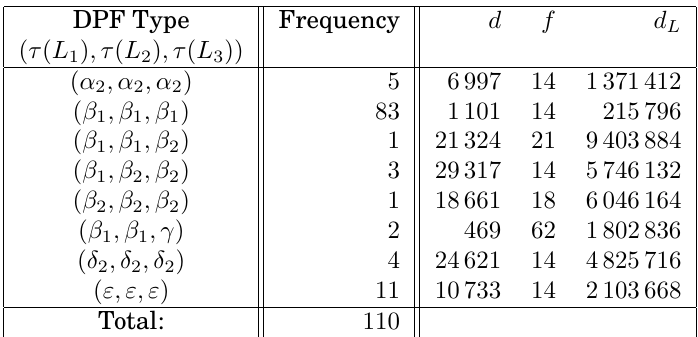
Table 27: Types of triplets with non-split and split ramified primes.